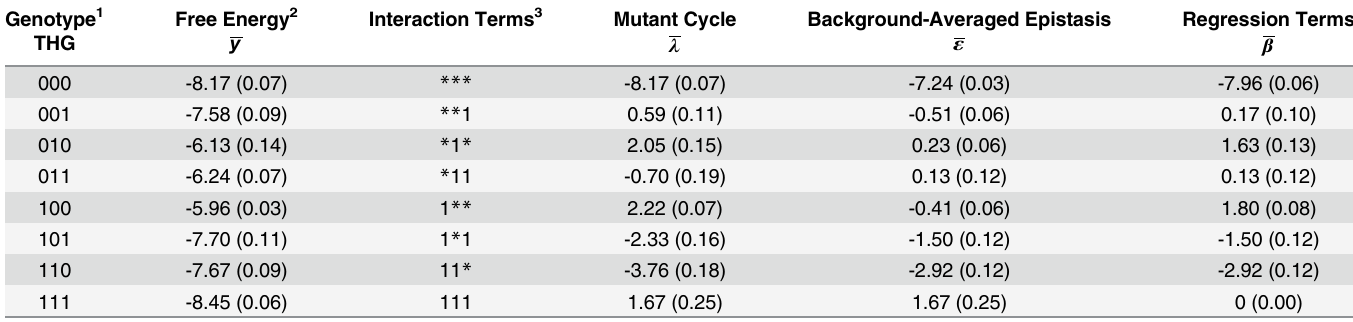
Table 1. Interaction terms after applying the three different transforms to the PDZ – ligand dataset with three mutable positions: three-way mutant cycle, background-averaged epistasis, and regression (to second order). Genotype